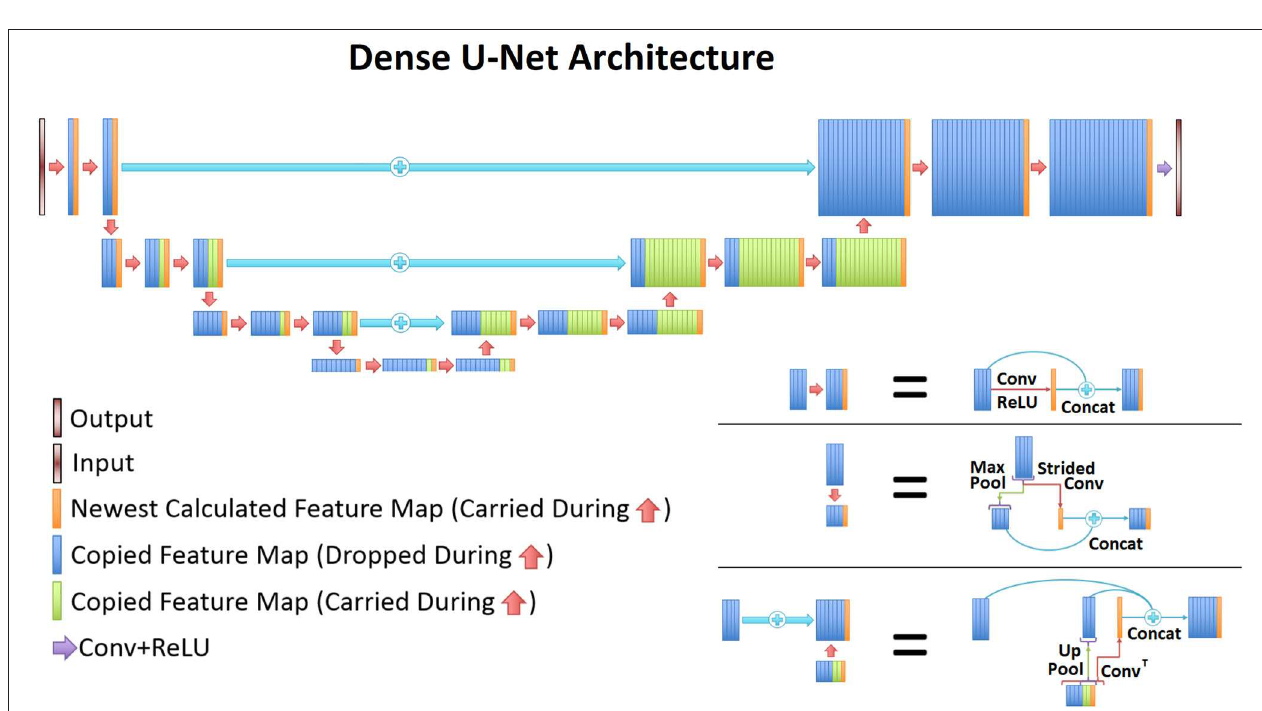
FIGURE 2 | The general D-UNet architecture is displayed. Each forward convolution consisted of a convolutional layer and a concatenation process. This concatenation carries over important features which can be used to make the next layer more intelligent. In addition to local concatenations, certain features were concatenated to deeper layers in the network. More specifically, every feature map that is produced from a convolution is carried over to the end. Maxpooled features are not, since a higher resolution of the feature already exists. This allows for prior information to improve the overall reconstruction quality. In order to use the most information possible, the last convolutional layer contains all of the carried over features.